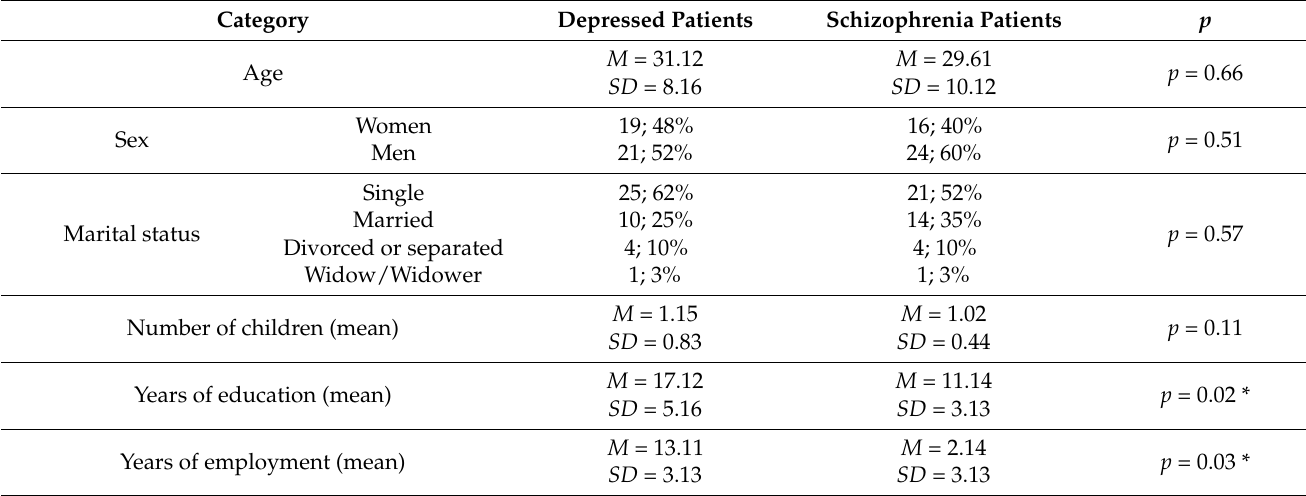
Table 1. Differences between groups regarding sociodemographic variables.